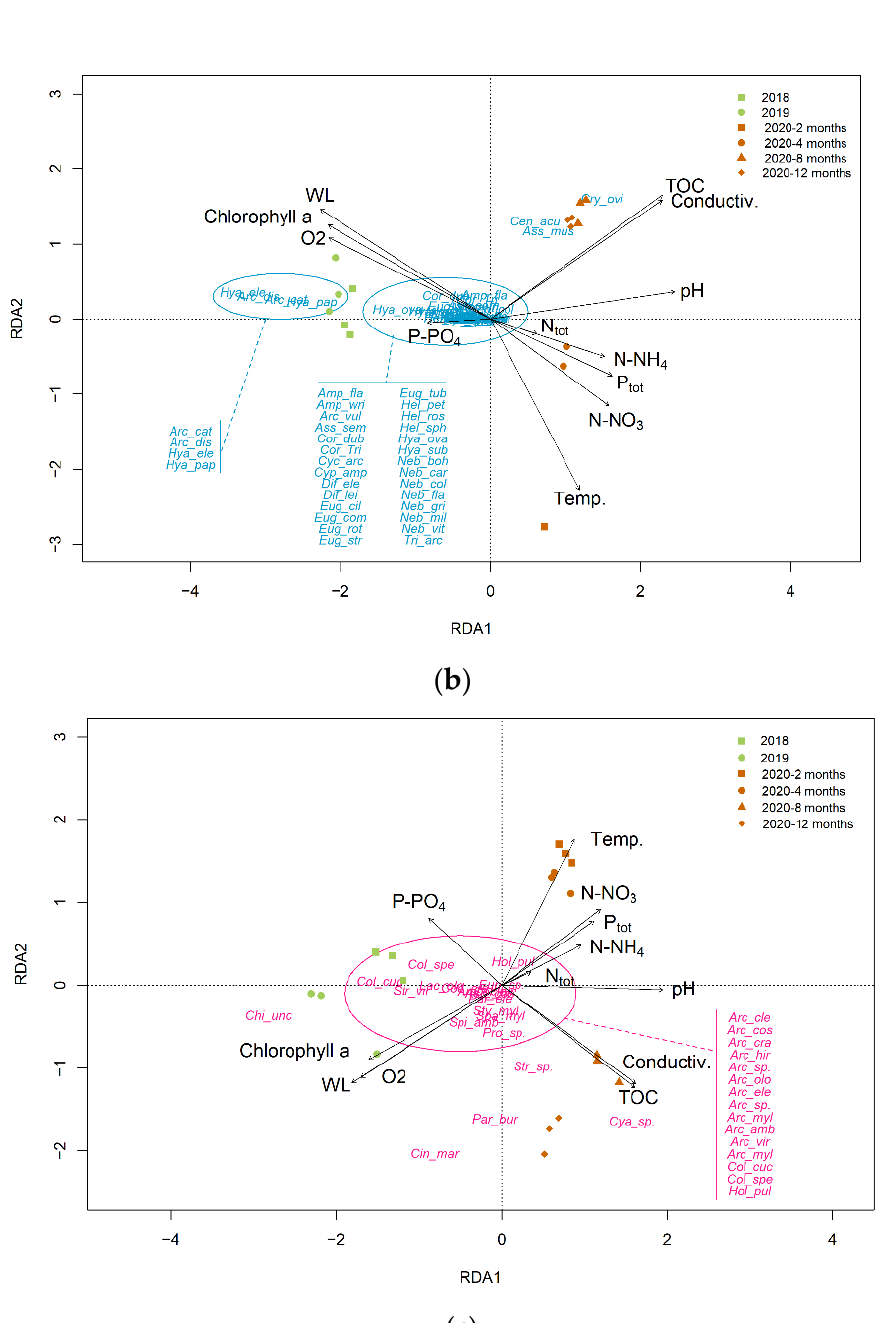
Figure 6. Redundancy analysis (RDA) triplots showing correlations between the studied organ- isms and environmental variables in investigated peatbog; ( a ) bacteria, heterotrophic flagellates, nematodes; ( b ) testate amoebae; ( c ) ciliates.